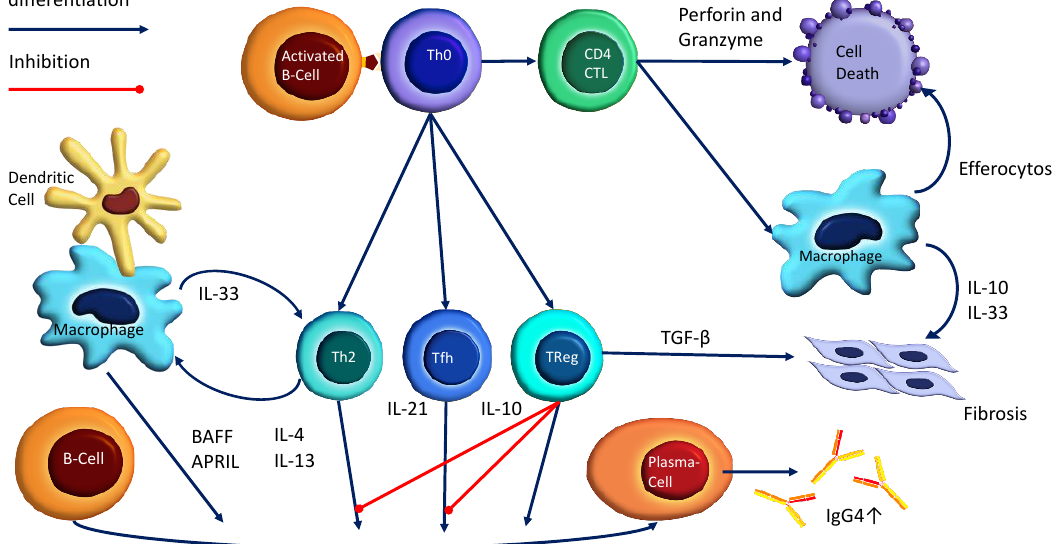
Figure 3. Schematic model of the major pathophysiologic pathways in AIP/IgG4-RD. Unknown antigens seem to be initiating events in the pathogenesis of AIP. Following the uptake and processing of an antigen by an activated B cell, peptide is presented to the CD4+ Th cell subpopulation in the context of MHC–II molecules. This, in turn, leads to the activation of different cytokine signaling pathways that ultimately determine their effector function. Th2 response and regulatory Th cells (Tregs) play a key role in the excessive production of IgG4 and tissue fibrosis. Additionally, IL-21, secreted by dysregulated follicular Th cells, is thought to induce the class switching of IgG4 [129]. Cytotoxic T lymphocytes (CD4 + CTLs) induce apoptosis and activate macrophages. Activated macrophages clear apoptotic cells by efferocytosis and profibrotic function via IL-10 and IL-33 cytokine secretion [130]. In addition, IL-33, produced by macrophages and dendritic cells, activates the Th2 response, whereas Th2 cytokines (IL-4 and IL-13) in turn activate macrophages. Finally, macro- phages and dendritic cells induce IgG4 class switching through B-cell-activating factor (BAFF) and a proliferation-inducing ligand (APRIL) secretion [132].